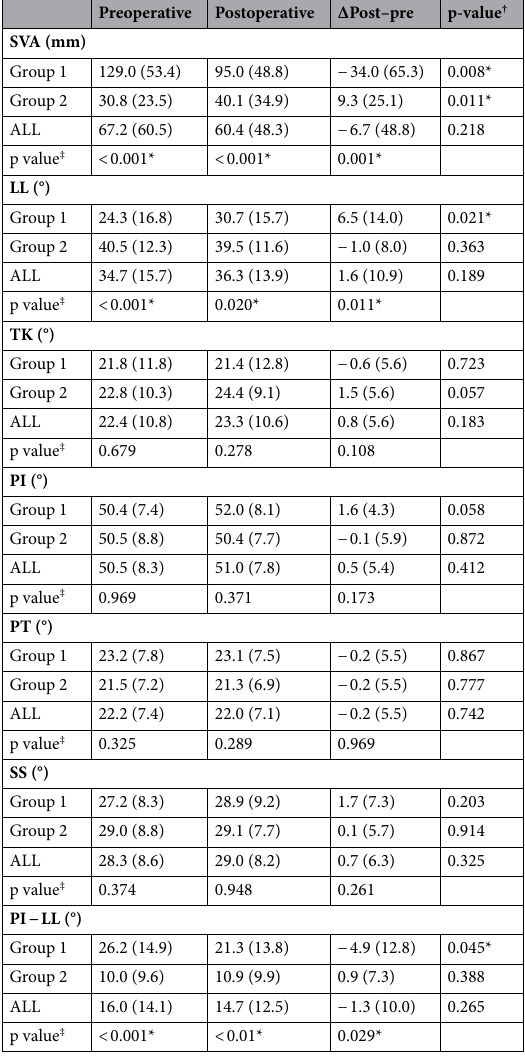
Table 3. Preoperative, postoperative, and change from pre- to postoperative sagittal measurements. † Comparison with pre op. ‡ Comparison between two groups. *Statistically